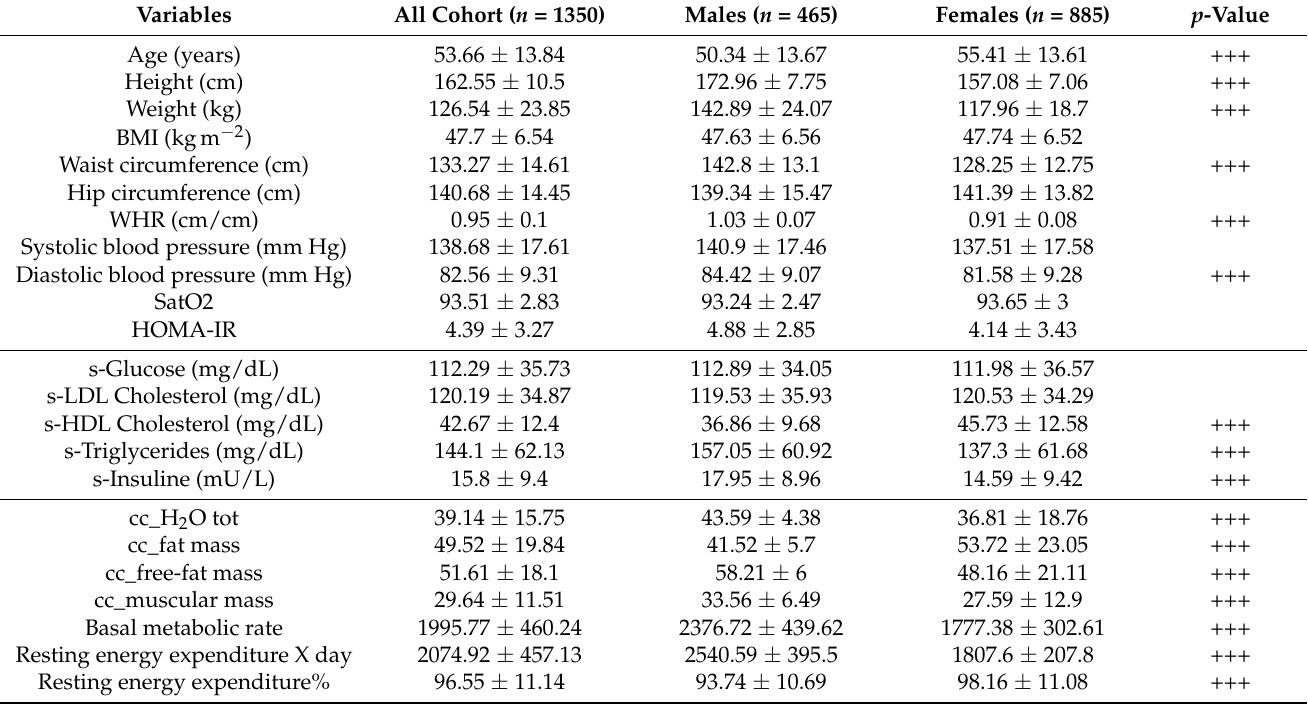
Table 1. Anthropometric characteristics of Piancavallo cohort data in total and separated by